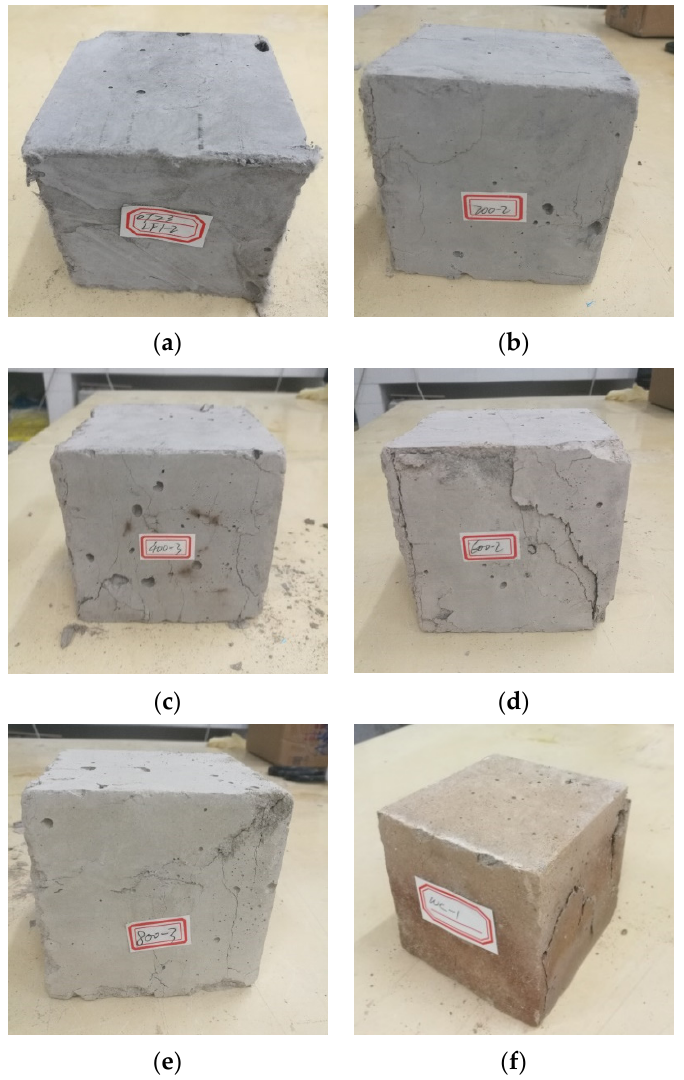
Figure 13. Failure modes of post-exposure PVA-ECC cubes after compression tests: ( a ) 30 ℃ , ( b ) 200 ℃ , ( c ) 400 ℃ , ( d ) 600 ℃ , ( e ) 800 ℃ , ( f ) 1200 ℃ .